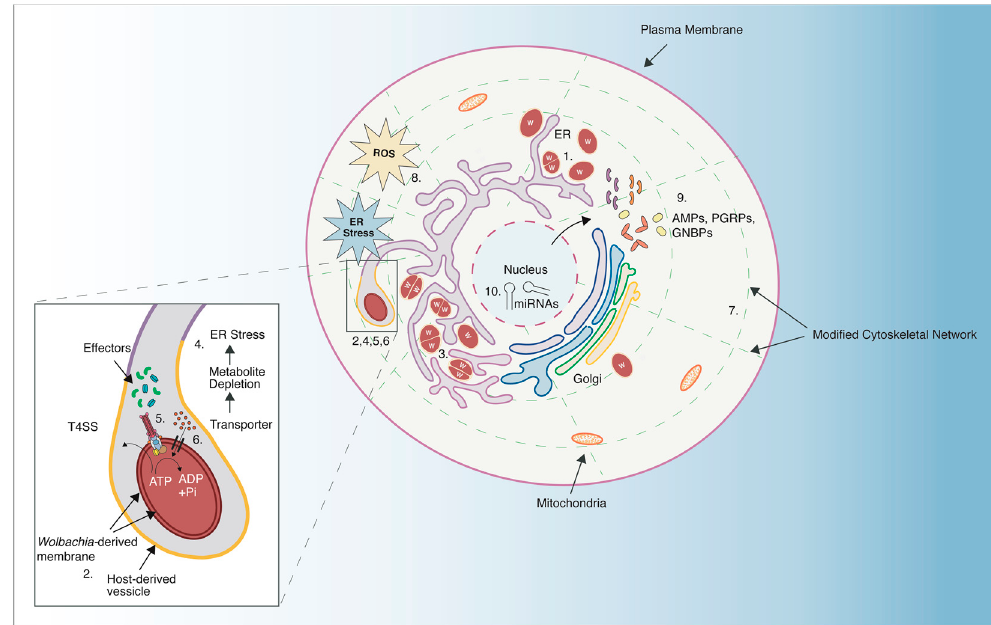
Figure 1. Wolbachia modifies the intracellular environment of the host. 1. Wolbachia typically exhibits a perinuclear localization, and closely associates with host derived-membranes ( Wolbachia are marked with a “W”). Wolbachia associates with the ER in particular, which results in atypical ER morphologies, including expansion and swelling; 2. Wolbachia are enclosed by three distinct membranes: a host derived vesicle (likely of Golgi-origin), and two Wolbachia derived membranes (inset); 3. During Wolbachia replication, daughter cells temporarily share the host-derived membrane, which later abscises; 4. Wolbachia have been observed fused to the ER, and having a direct connection to the ER lumen (inset), likely facilitating the exchange of proteins or other metabolites; 5. The Type Four Secretion System (T4SS) allows Wolbachia to export effector proteins directly to the host (inset); 6. The Wolbachia genome also encodes a number of transporters that likely facilitate uptake of nutrients from the host; 7. In addition to associating with intracellular membranes, Wolbachia is known to alter the host cytoskeleton (depicted as green dashed lines); 8. The presence of Wolbachia results in the production of reactive oxygen species (ROS), contributing to cellular stress; 9. Lastly, Wolbachia is often associated with upregulation of immune-related genes and pathways including antimicrobial peptides (AMPs), Gram-negative binding proteins (GNBPs), peptidoglycan recognition proteins (PGRPs), and miRNAs (10).